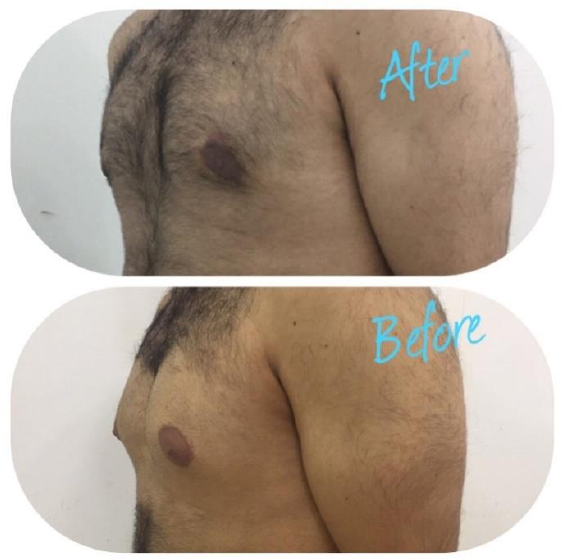
Figure 8 (b) Showing Simon 2B oblique view before and after